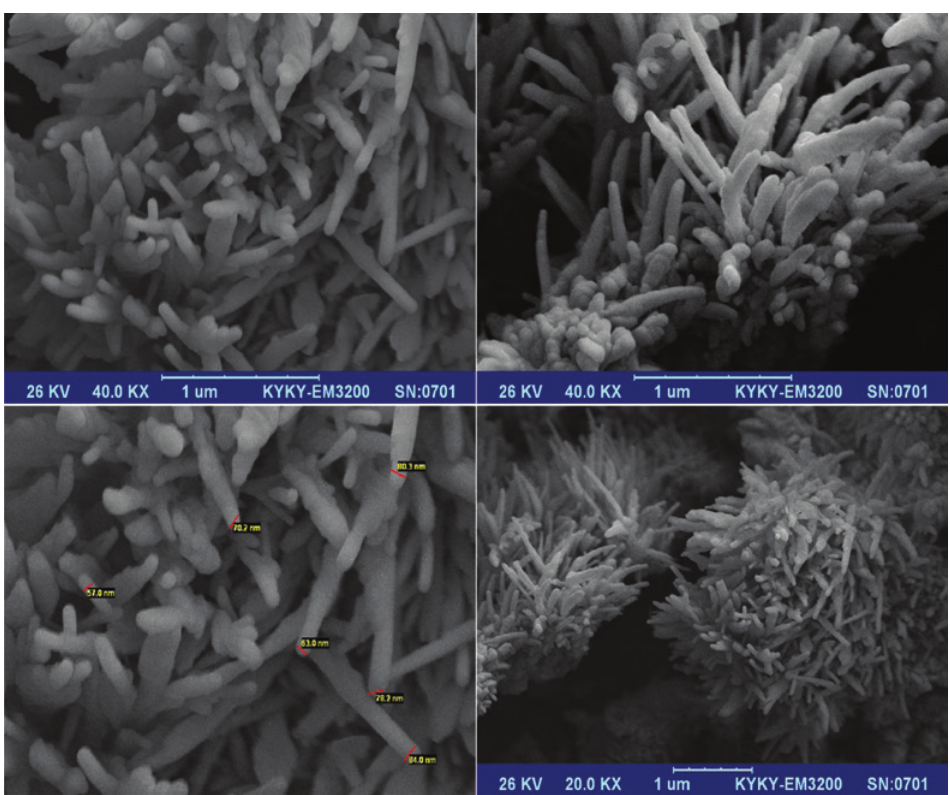
O nanoparticles synthesized in the presence of gelatin. 12 19